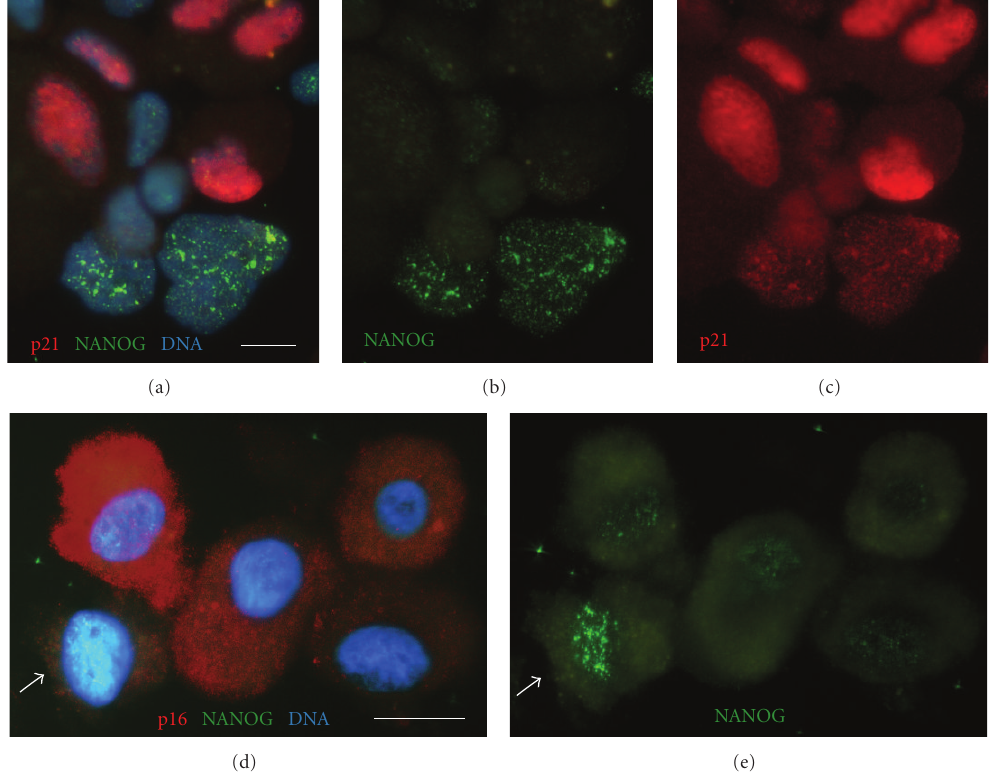
Figure 12: The antagonism between expression of NANOG and senescence regulators at the late presenescence and senescence phases: ((a)–(c)) late presenescence (MI = 0.1%): in the group of ten cells it is seen that nuclear staining of NANOG is found only in the cells with enlarged nuclei, where NANOG staining intensity is inverse to the staining for p21; ((d), (e)) senescence (MI = 0)—a rare NANOG-positive cell was encountered (arrowed), which has the weakest staining for p16 in its cytoplasm among five cells of the group. ((a), (d)) were imaged through the BRG filter; ((b), (e))—through blue, and (c)—through green filter. Scale bars = 10 μ m.